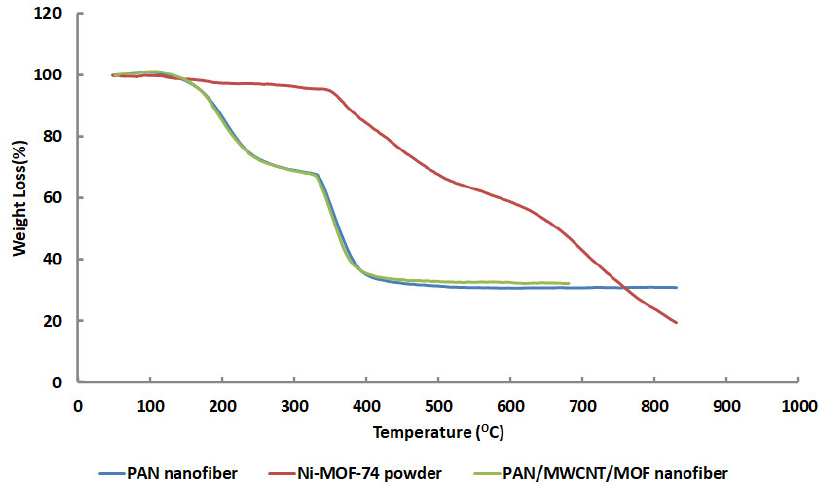
Figure 6. SEM and TEM images of electrospun nanofiber ( a ) PAN; ( b ) PAN/MWCNT; ( c ) PAN/MOF; ( d ) PAN/MWCNT/MOF.